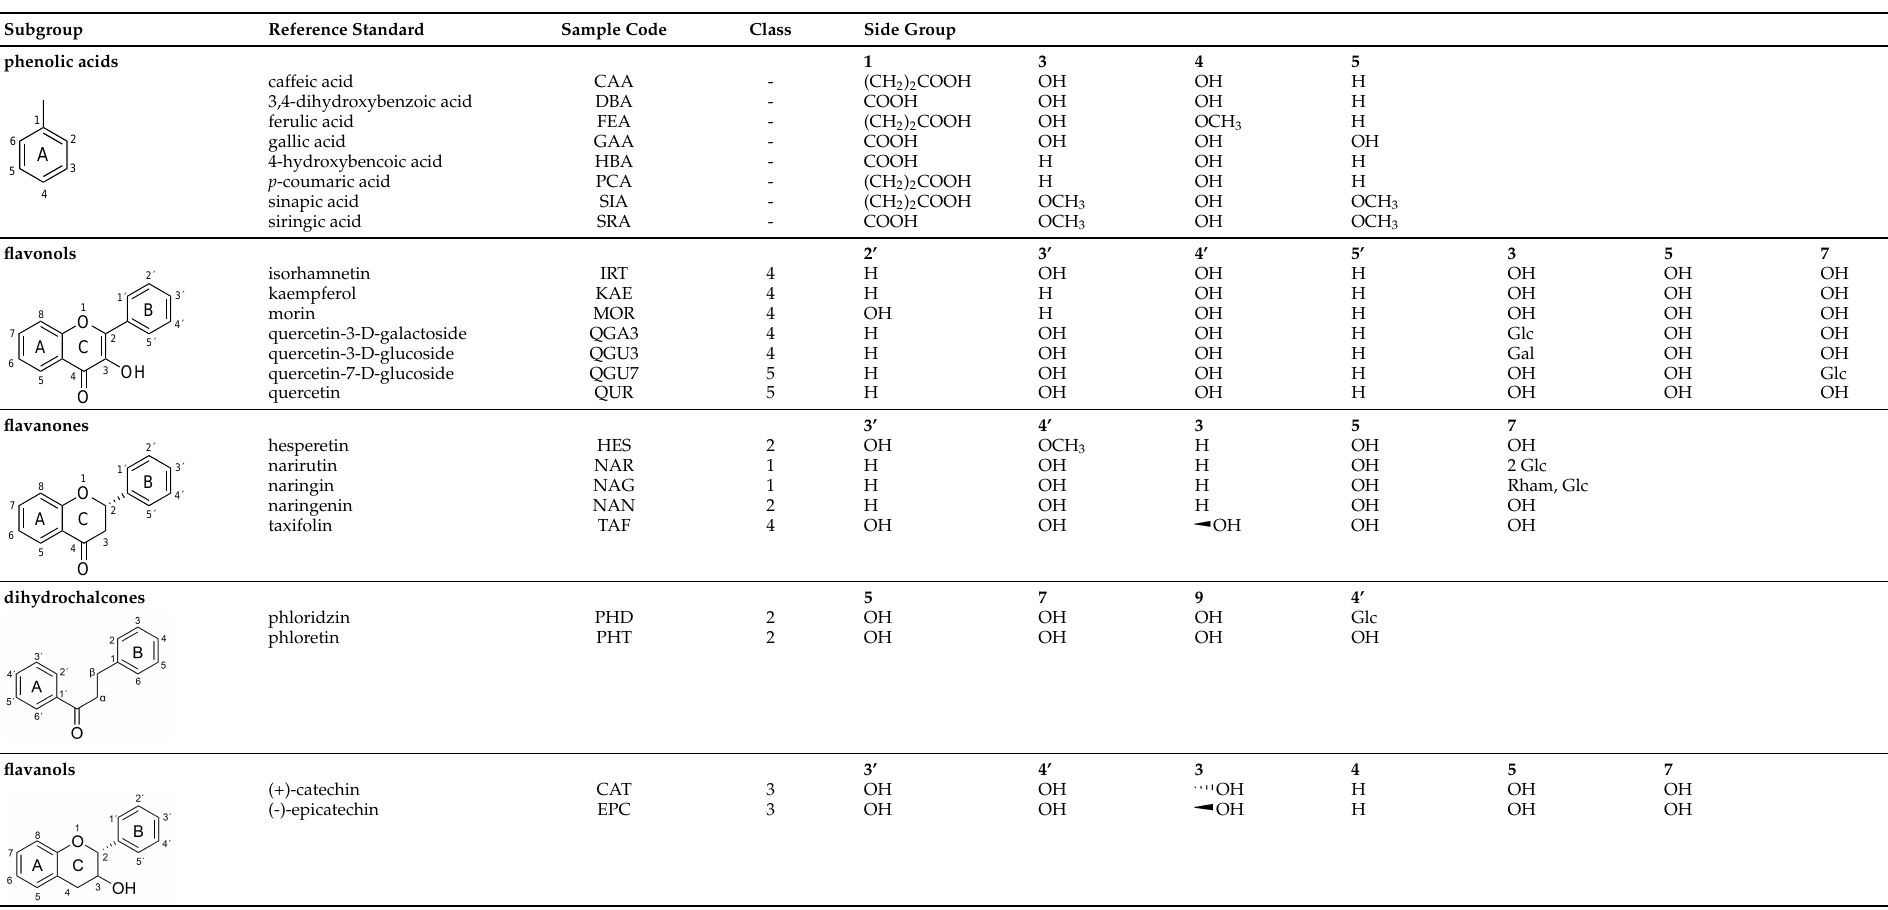
Table 1. The phenolic compounds analyzed in this study (phenolic acids and subgroups of flavonoids) along with reference standards, character codes, and side groups (reproduced and slightly modified from Table 1 in Platzer et al. [15] with